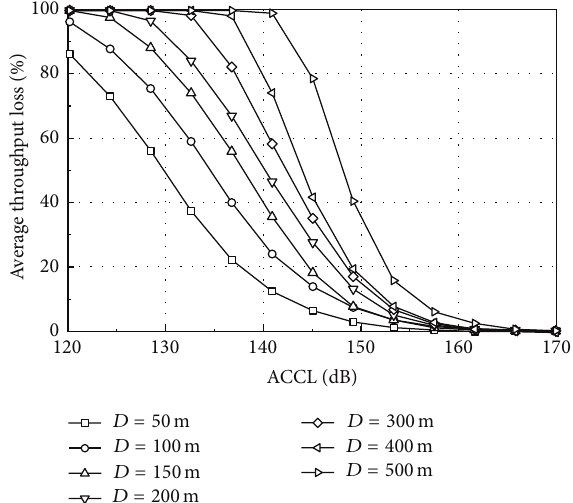
Figure 12: Throughput loss of unsynchronized downlink opera-